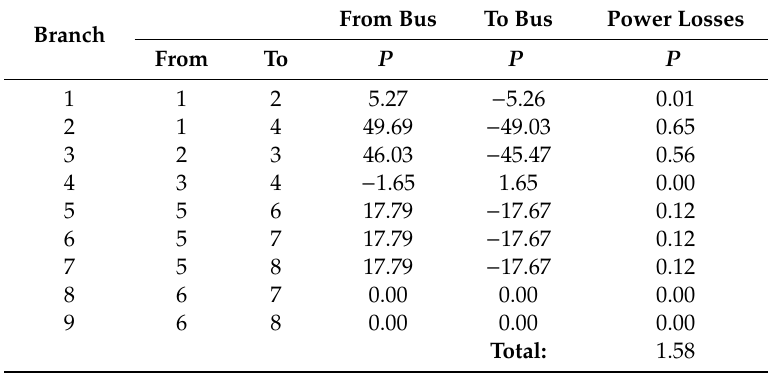
Table A53. Results of the mixed AC / DC PF calculations in Case 7-6. DC branch